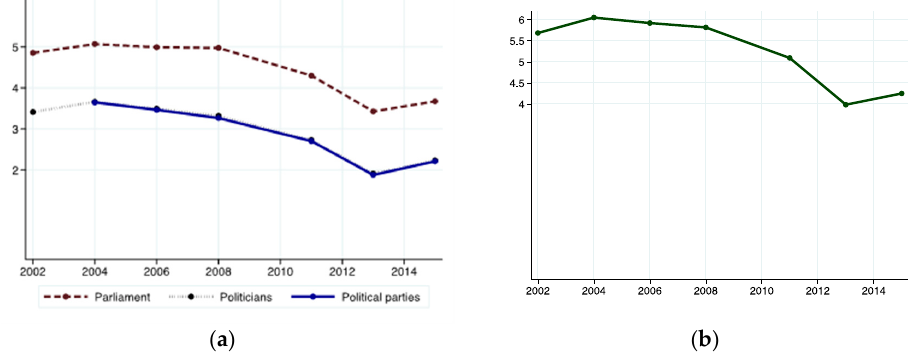
Figure 1. Evolution of political trust and satisfaction with democracy. ( a ) Average trust in Parliament, politicians, and political parties on a 0–10 scale. ( b ) Average satisfaction with the way in which democracy works in Spain (0–10 scale). Source: European Social Survey, rounds 1–7 (Spain). Societies 2018 , 8 , x FOR PEER REVIEW